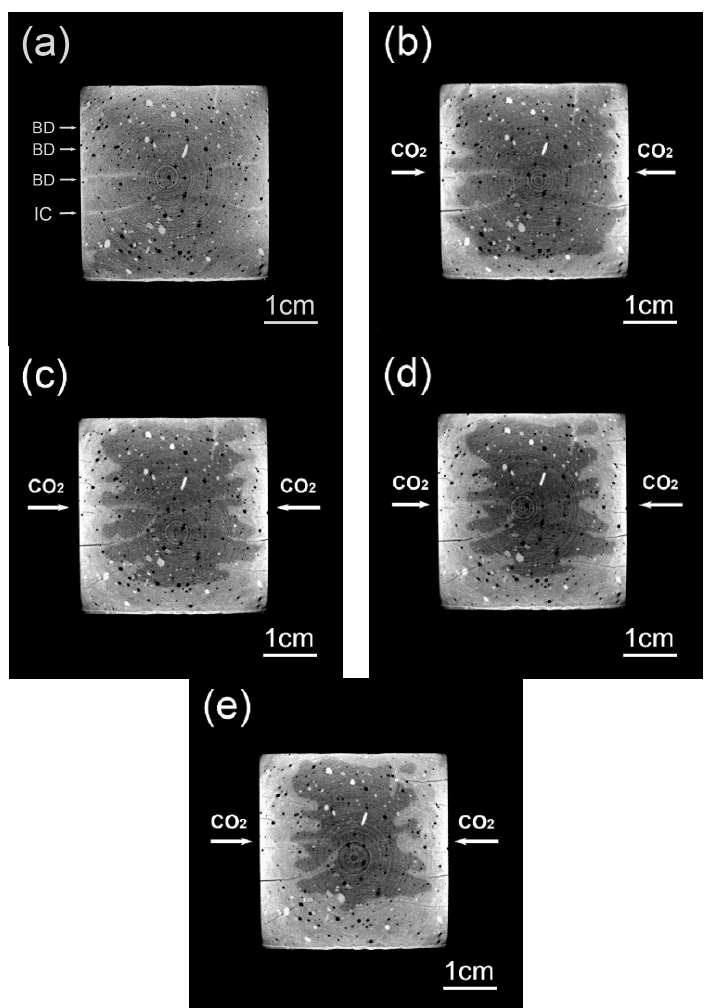
Figure 4. Typical cross-sectional images rendered from specimens after ( a ) 0, ( b ) 3, ( c ) 7, ( d ) 14, and ( e ) 28 days of carbonation, respectively. BD: bright dot caused by natural carbonation; IC: intersected crack.